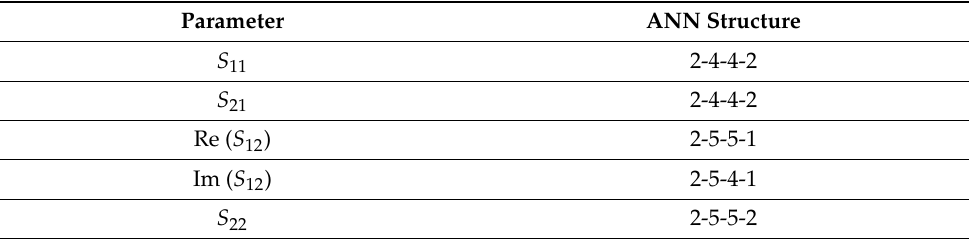
Figure 3. Illustration of the model based on using artificial neural networks for the tested GaN HEMT: ( a ) S 11 , S 21 , S 22 , and ( b ) S 12 . Table 1. Structure of the trained artificial neural networks: the number of neurons for the input, first hidden, second hidden, and output layers.